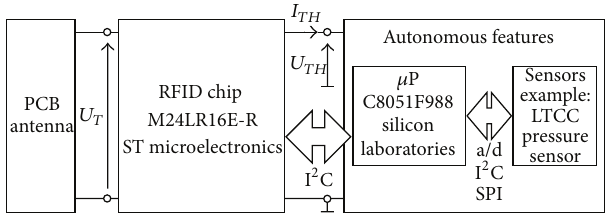
Figure 4: Block diagram of the elaborated